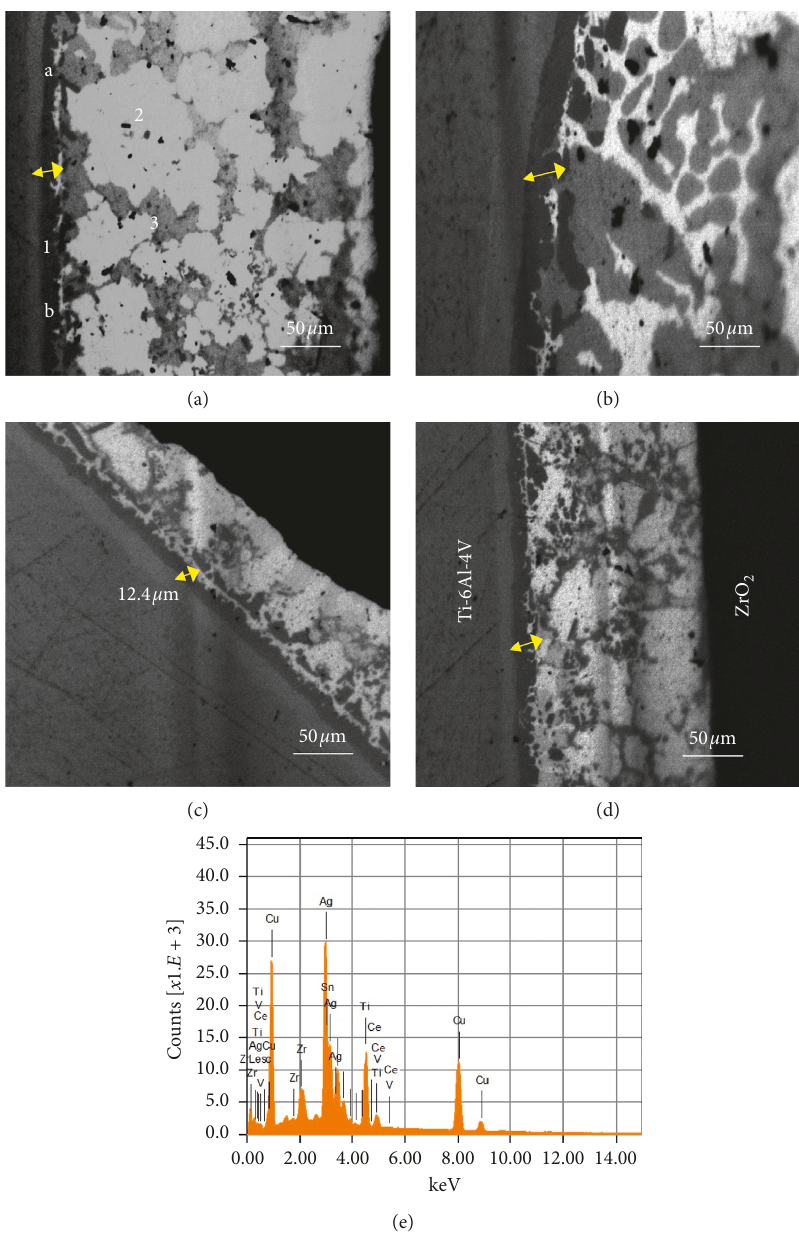
Figure 8: The cross-sectional SEM image of the ZrO (b) x � 0.03; (c) x � 0.05; (d) x � 0.1; (e) EDS analysis of